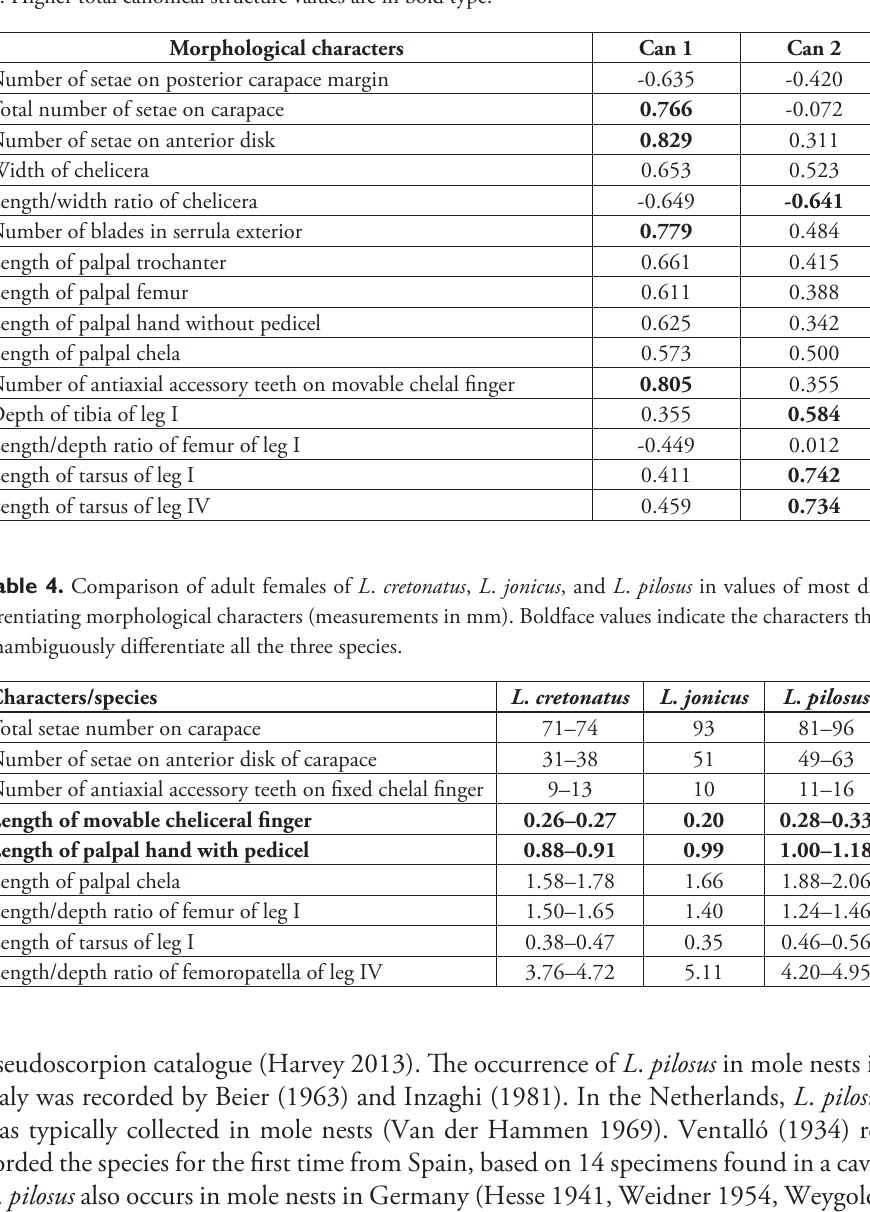
Table 3. Results of the canonical discriminant analysis (CDA 9, Fig. 9) based on 15 morphological characters measured/scored for 19 specimens of L . cretonatus , L . jonicus , and L . pilosus . Values of the total canonical structure listed in the table express correlations of characters with canonical axes (Can 1, Can 2). Higher total canonical structure values are in bold